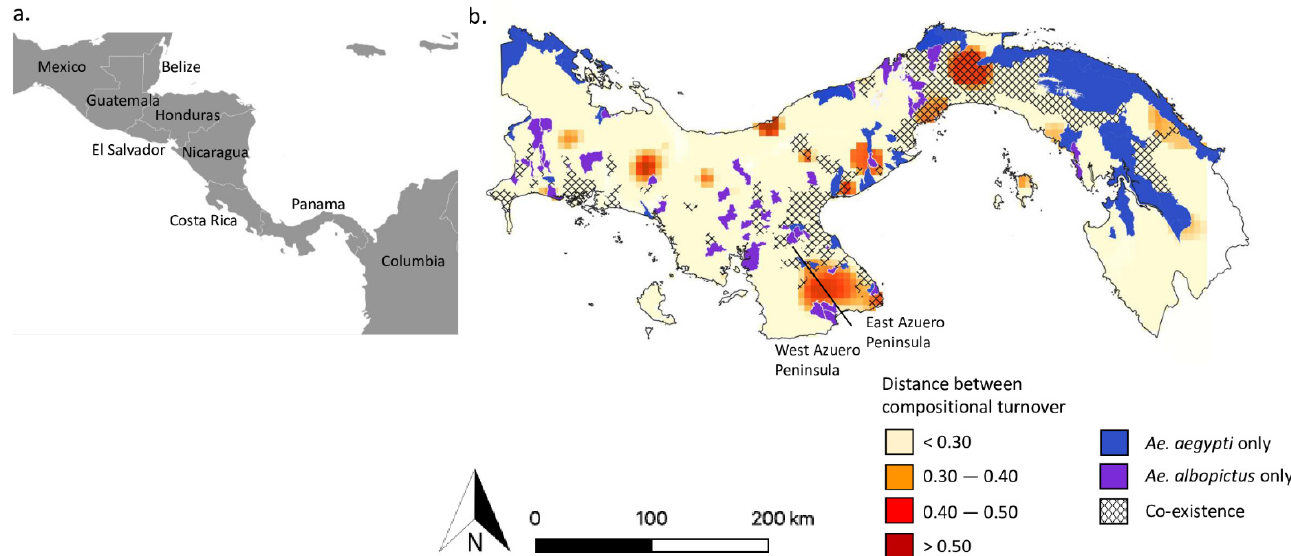
Figure 1. Putatively adaptive loci are predicted in Ae. aegypti populations within areas of species co-existence. ( a ) The location of Panama within Central America. ( b ) Counties with Aedes co-occurrence (dashed areas) are shown based on the recent species distributions as reported by Bennett et al. from 2018 and the Panamanian Ministry of Health (MINSA) in 2017 [21]. The co-occurrence data are overlaid onto a map with red coloured areas representing the potential environmental adaptation of Ae. aegypti from Bennett et al. [36]. These areas were identified through a Generalised Dissimilarity